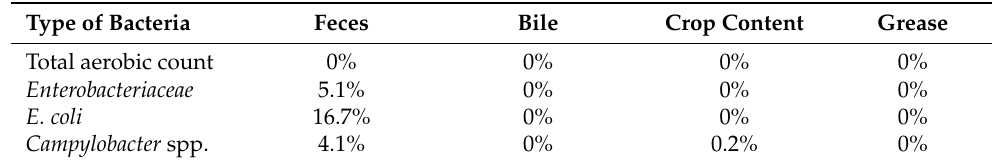
Table 4. The probability (%) that a small visible contamination results in at least a 0.5 (log 10 CFU) increase in the total bacterial load of the average chicken carcass (1600 g).